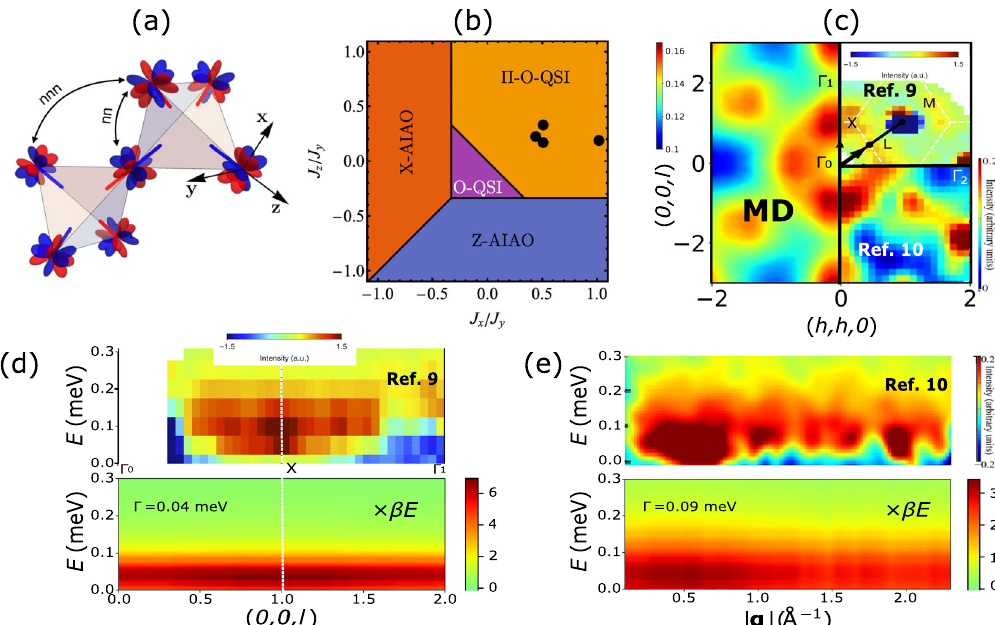
Fig. 1 Quantum spin liquid in a pyrochlore magnet and its experimental rami fi cations. a Depiction of a pyrochlore lattice with octupolar components forming 2-in-2-out ice states, and showing representative nearest neighbor (nn) and next-nearest neighbor (nnn) bonds. b Our model parameter sets are shown with black dots, superposed on the mean- fi eld phase diagram of ref. 20 . c Dynamical structure factors at T = 0.06 K integrated over the energy range 0.00 to 0.15 meV obtained from classical molecular dynamics (MD) for 8192 spins along with the corresponding comparison with ref. 9 ( T = 0.035 K) and ref. 10 ( T = 0.06 K, with an additional background subtraction). The plots reported in the published references were adapted for the purpose of comparison with our results. Special points in the Brillouin zone are also shown. d , e The dynamical structure factor as function of energy and momentum using the MD data (for 1024 sites) compared to experiment. The quantum-classical correspondence dictates that the MD data be rescaled 23 by the factor β E ( β = 1/ k B T where k B is the Boltzmann factor, and E is the neutron energy transfer). Panel d is for the momentum (0, 0, l ) cross section ( Γ 0 → X → Γ 1 ) and panel e is the powder average. For panels c , d , e the numerically optimized Hamiltonian (parameter set no. 2 with both nearest neighbor and next-nearest neighbor terms, see Supplementary Table 1) was simulated. Additional Lorentzian convolution of width Γ was applied to mimic the limited experimental resolution, based on values reported in ref. 9 and ref. 10 . The color scheme used for the theoretical calculation and the two experiments differs, and in the absence of additional information only the relative variations should be compared. Note that the high intensity around q = (1, 1, ± 1) and (2, 2, − 2) seen in the experimental inset in panel c results from an imperfect subtraction (using high-temperature data) of the nuclear Bragg peaks, which are absent from our theoretical calculations. The same is true in panel e at ∣ q ∣ ~ 1 Å − 1 and ∣ q ∣ ~ 2 Å − 1 , where the maxima of intensity originate from imperfect subtraction of nuclear Bragg